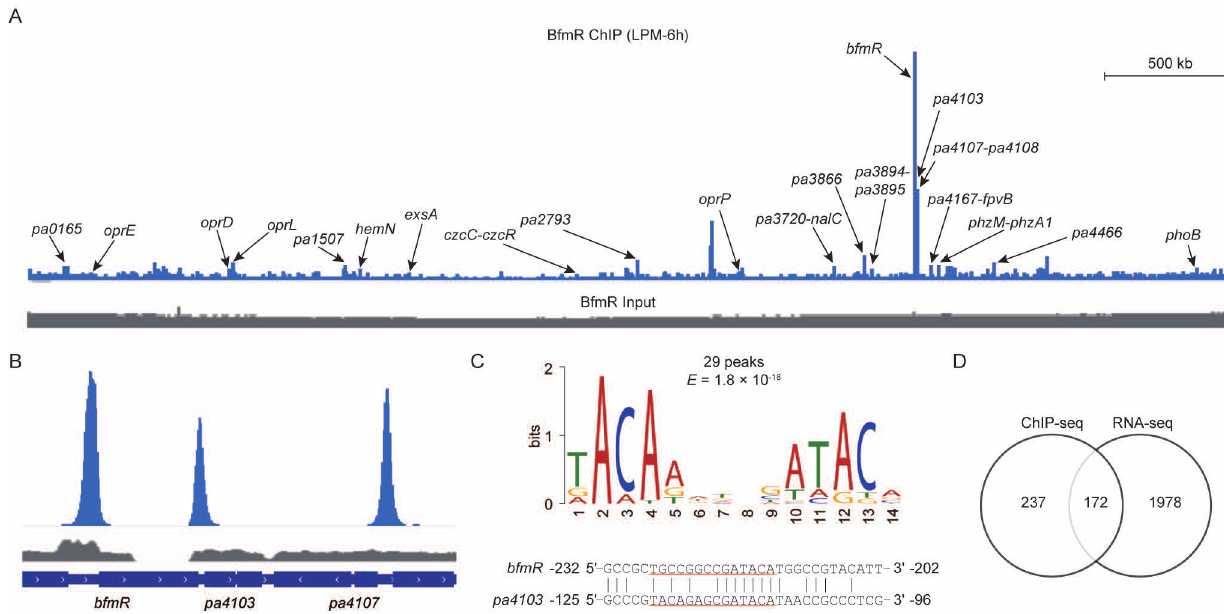
Figure 1. Analysis of BfmR ChIP-seq. ( A ) A representative image of BfmR ChIP-seq result using Integrated Genome Viewer. Bacteria were cultured in low-phosphate minimal (LPM) for 6 h (LPM-6h). ChIP sample (blue) and input control sample (grey) were shown as indicated. Arrows indicate the gene promoters associated with the ChIP-seq peaks. ( B ) Pattern of BfmR ChIP-seq peaks for the promoter regions of bfmR , pa4103 , and pa4107 . ( C ) The most significant motif generated by the MEME tool [34] using 101 bp centered on the peak summit of the top 30 peak sequences (Data set 1, sheet 1) with default parameter values. The height of each letter represents the frequency of each base in different locations in the consensus sequence. The 14 nt motif was present in 29 BfmR binding sites with an E-value of 1.8 × 10 -18 (upper panel). The location of the conserved promoter element generated by MEME ( upper panel ) on the BfmR-protected region of either bfmR or pa4103 promoter [11] was underlined (lower panel). ( D ) Venn diagram of integrated ChIP-seq and RNA-seq results showing the direct and indirect targets of BfmR (Data set